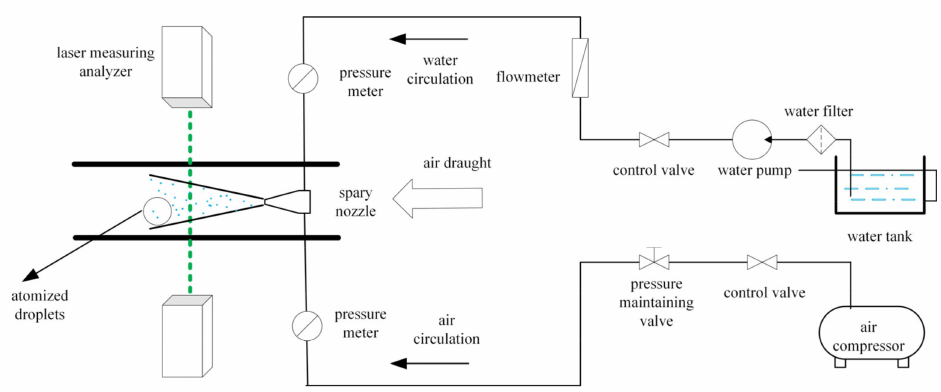
Figure 2. Schematic diagram of experimental visual system of droplet evaporation process.